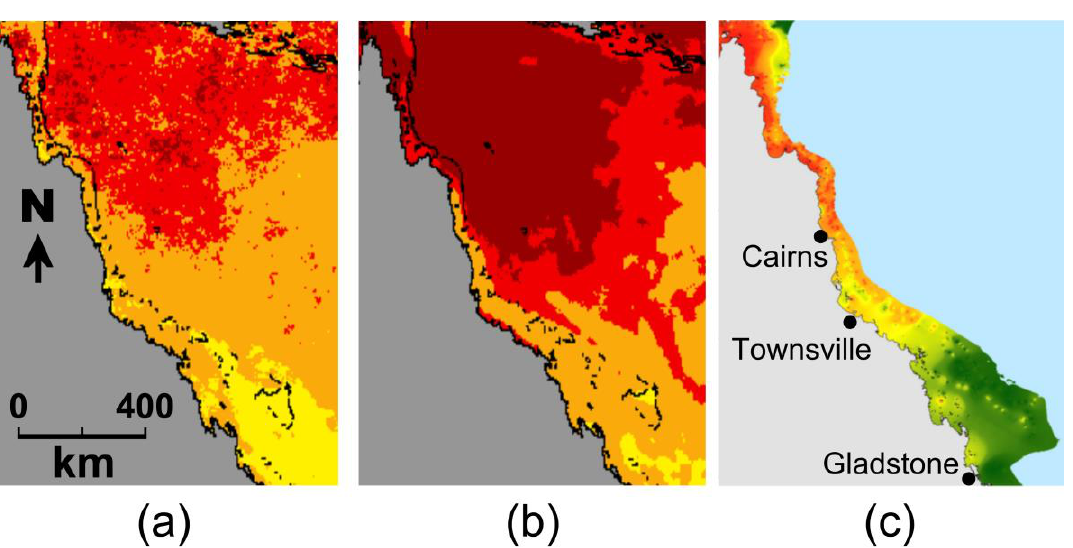
Figure 4. Comparison between Bleaching Alert Area (BAA) for the 2016 bleaching event on the Great Barrier Reef (BAA version 2.0 ( a ) and BAA version 3.1 ( b )) and bleaching observations ( c ). BAA data were obtained from the NOAA Coral Reef Watch website (www.coralreefwatch.noaa.gov). The BAA categories are: yellow (Watch ≡ 0 < HS < 1), orange (Warning ≡ 0 < DHW < 4), light red (Alert Level 1 ≡ 4 ≤ DHW < 8) and dark red (Alert Level 2 ≡ DHW ≥ 8). Bleaching observations were obtained via extensive aerial surveys (totalling 1156 reefs): dark green (<1% of corals bleached), light green (1–10%), yellow (10–30%), orange (30–60%), red (>60%) (from [26]).